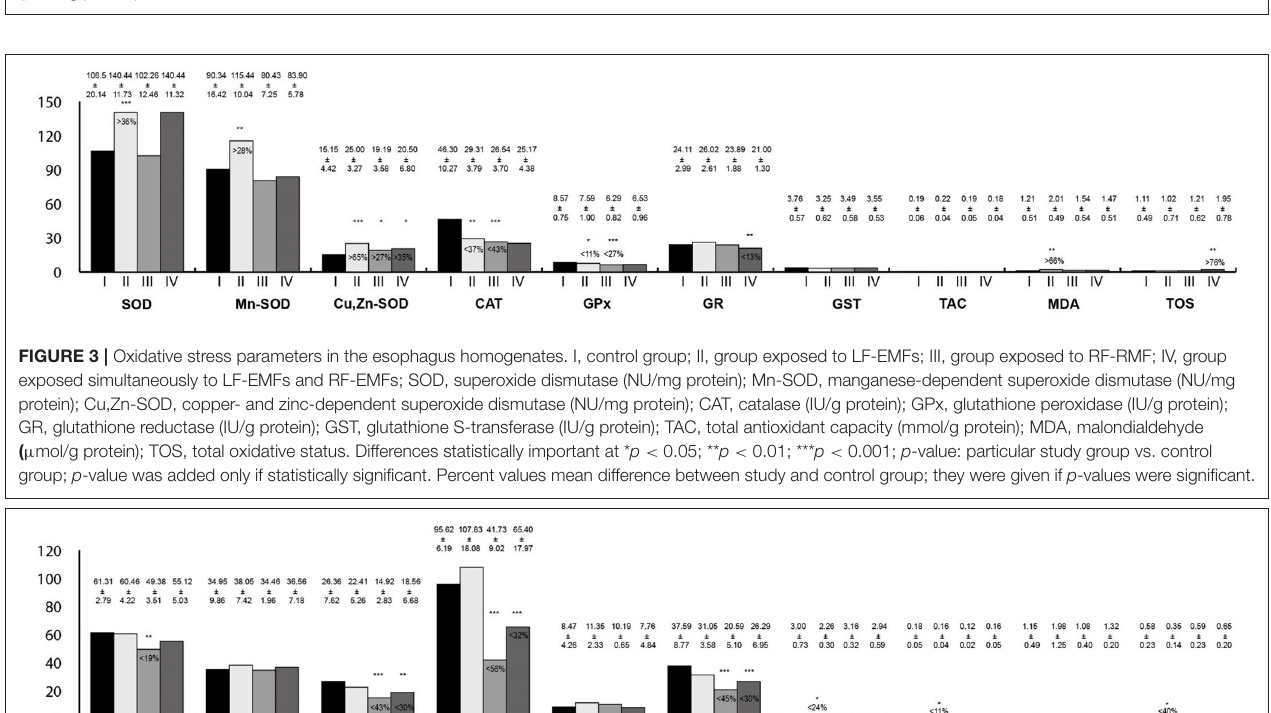
FIGURE 2 | Oxidative stress parameters in the salivary gland homogenates. I, control group; II, group exposed to LF-EMFs; III, group exposed to RF-RMF; IV, group exposed simultaneously to LF-EMFs and RF-EMFs; SOD, superoxide dismutase (NU/mg protein); Mn-SOD, manganese-dependent superoxide dismutase (NU/mg protein); Cu,Zn-SOD, copper- and zinc-dependent superoxide dismutase (NU/mg protein); CAT, catalase (IU/g protein); GPx, glutathione peroxidase (IU/g protein); GR, glutathione reductase (IU/g protein); GST, glutathione S-transferase (IU/g protein); TAC, total antioxidant capacity (mmol/g protein); MDA, malondialdehyde ( µ mol/g protein); TOS, total oxidative status.